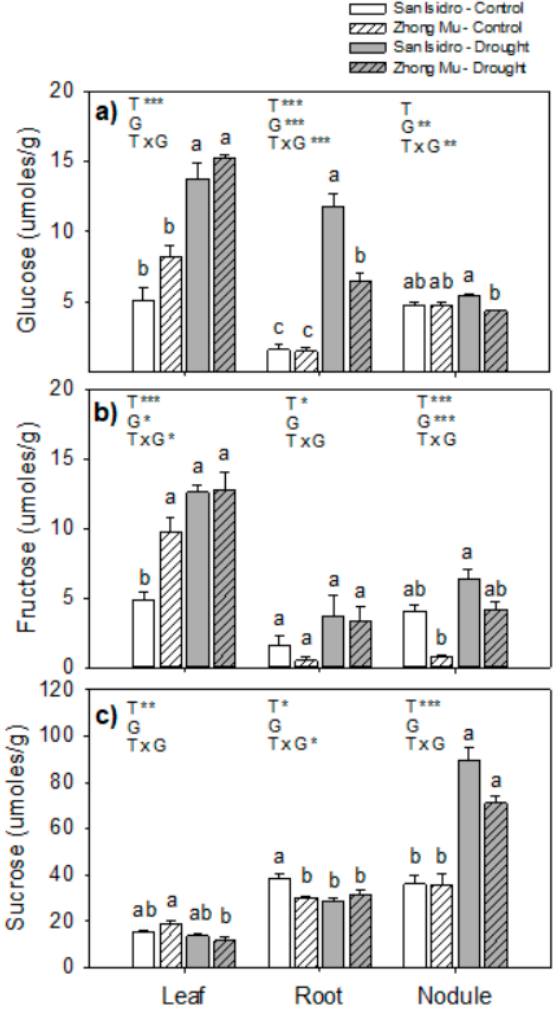
Figure 7. Soluble sugars content in leaves, roots and nodules under control and drought condition in two cultivars of Medicago sativa : San Isidro and Zhong Mu: ( a ) glucose, ( b ) fructose, ( c ) sucrose. Each value represents the mean ± SE ( n = 6). The different letters indicate significant differences ( p < 0.05). Asterisks indicate significant differences: * p < 0.05, ** p < 0.01, *** p < 0.001, in the two-way ANOVA for water-stress and cultivars.